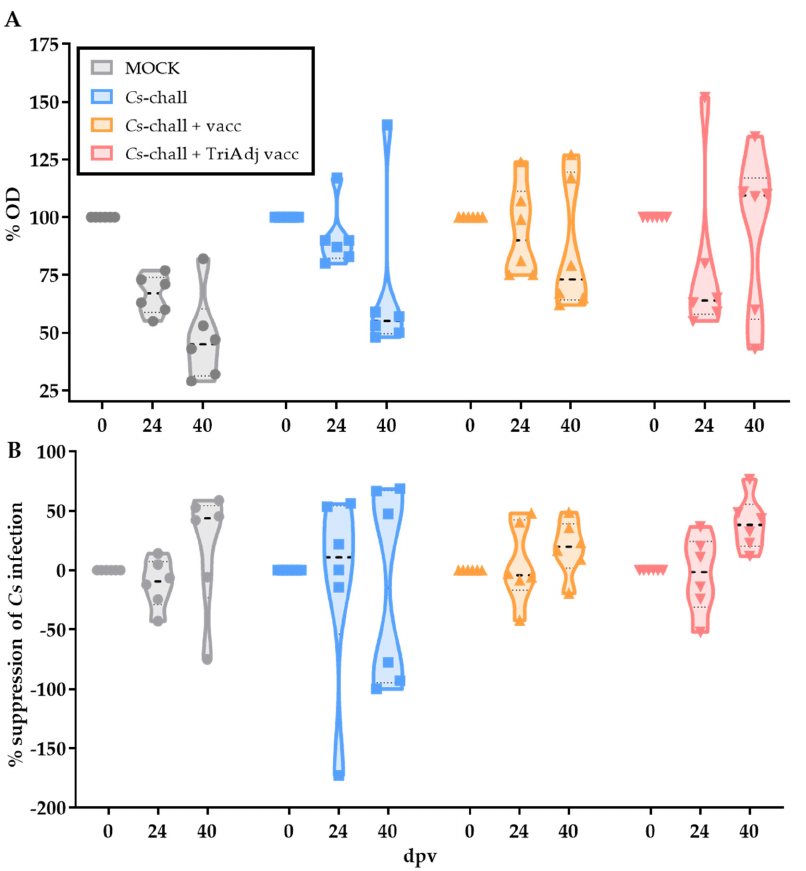
Figure 4. The systemic anti- Cs humoral immune response is equivalent in pre-exposed, challenged, and vaccinated/challenged pigs. The humoral immune response for each individual pig was analyzed in MOCK (gray), C. suis challenged ( Cs -chall, blue), C. suis challenged + vaccinated ( Cs -chall + vacc, orange), and C. suis challenged + Tri Adjuvant vaccinated ( Cs -chall + TriAdj vacc, red) pigs. ( A ) Anti- C. suis serum IgG levels at stated days post first vaccination (dpv, x-axis) were analyzed via peptide ELISA. While no significant di ff erences were obtained, serum anti- Cs IgG levels were elevated by number at 40 days post vaccination (10 days post challenge) in the TriAdj vaccinated pigs. ( B ) Neutralizing antibodiesinserumwereanalyzedbyinfectingHeLacellswith Cs inthepresenceofserum(1:10dilution). The % suppression of infection (y axis) was calculated via flow cytometry by dividing the infection rate at the day post first vaccination (dpv, x-axis) by the infection rate before challenge within the same animal. No between-group di ff erences were obtained. Values for individual pigs, medians, and 25 / 75 percentiles are